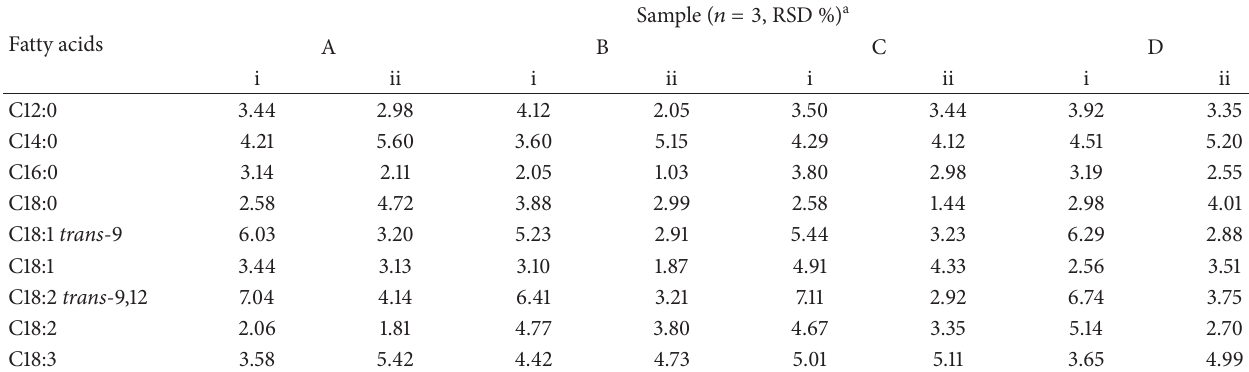
Table 6: Interday variation (RSD, %) for four studied samples by both methods employed. Fatty